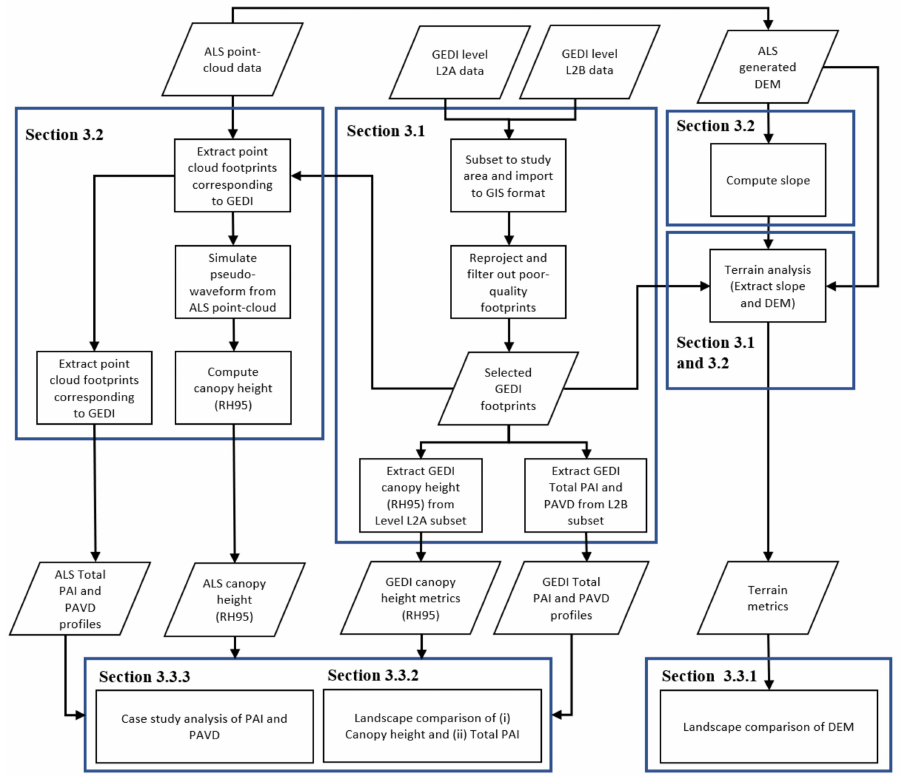
Figure 2. Overall methodology of the study. The input data layers are shown by the parallelograms and the rectangles show the process steps followed. The blue boxes and section numbers describe the location in the manuscript where each method is